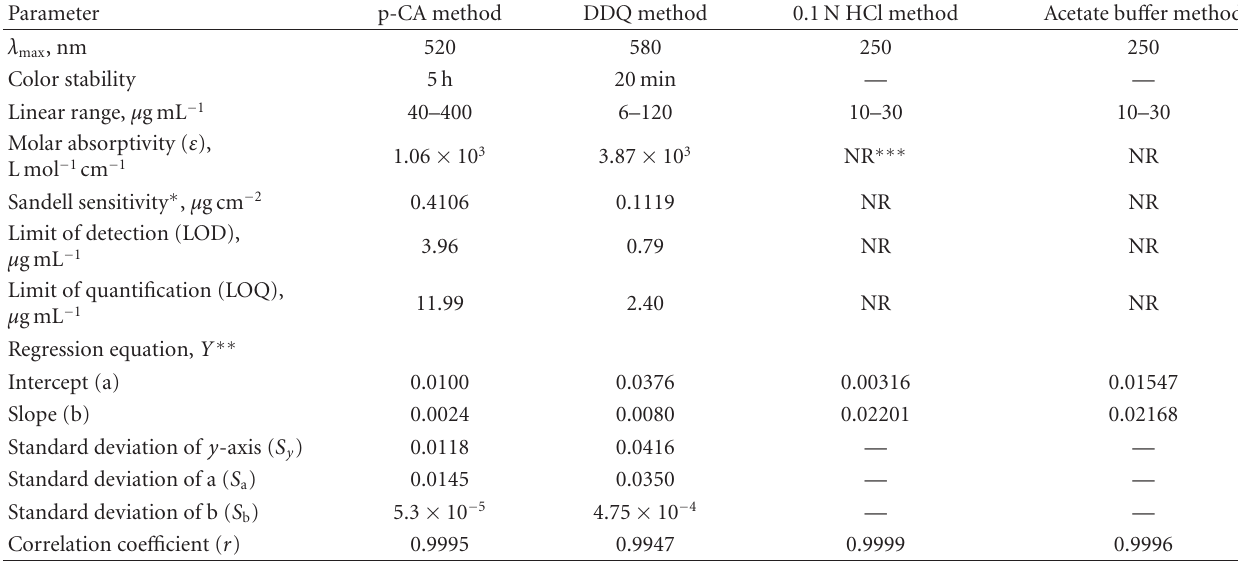
Table 1: Sensitivity and regression parameters of the proposed methods in comparison with the reported UV-spectrophotometric methods [10].